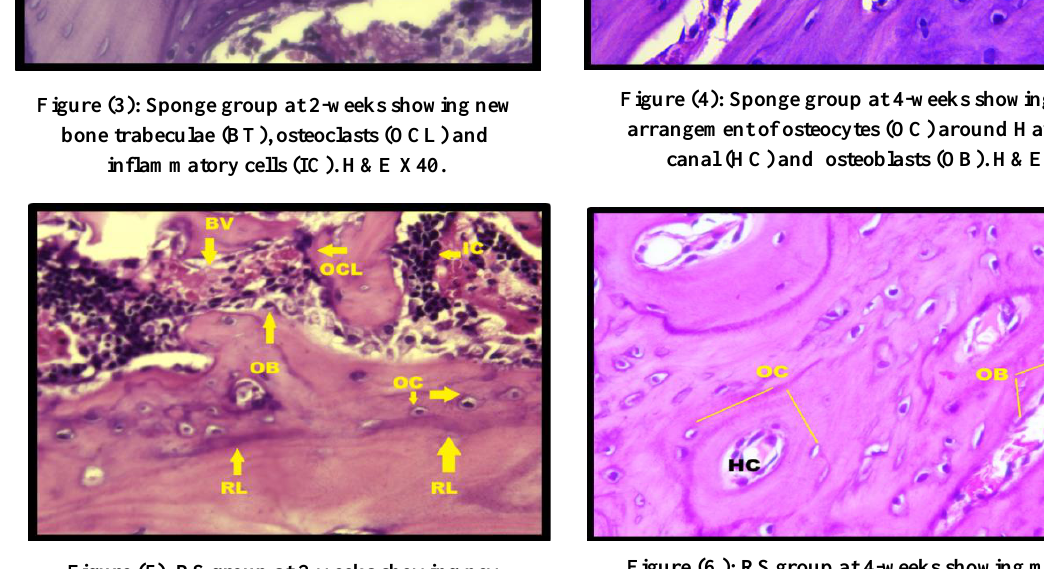
Figure (5): RS group at 2-weeks showing new bone filled by osteocytes (OC) lined by osteoblasts (OB), blood vessels (BV), inflammatory cells (IC), osteoclasts (OCL) and reversal line (RL). H&EX40